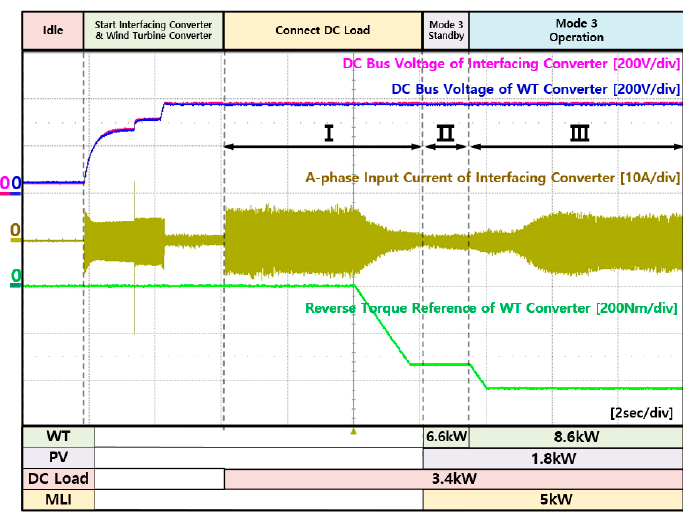
Figure 18. Experiment waveforms of interfacing converter and WT converter in mode 3.